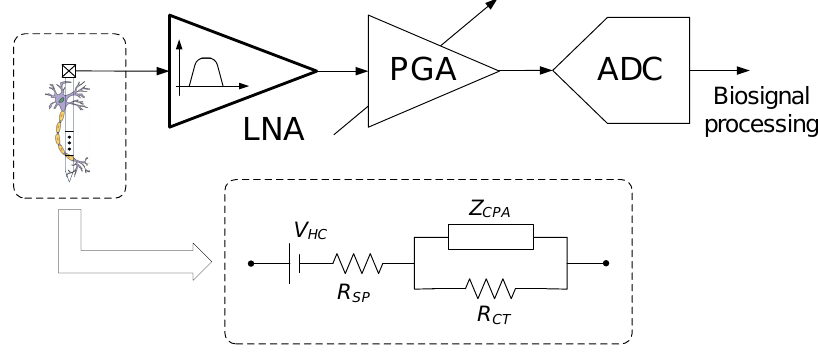
Figure 1. Simplified diagram of a typical neural recording channel and electrical model of the tissue-microelectrode interface